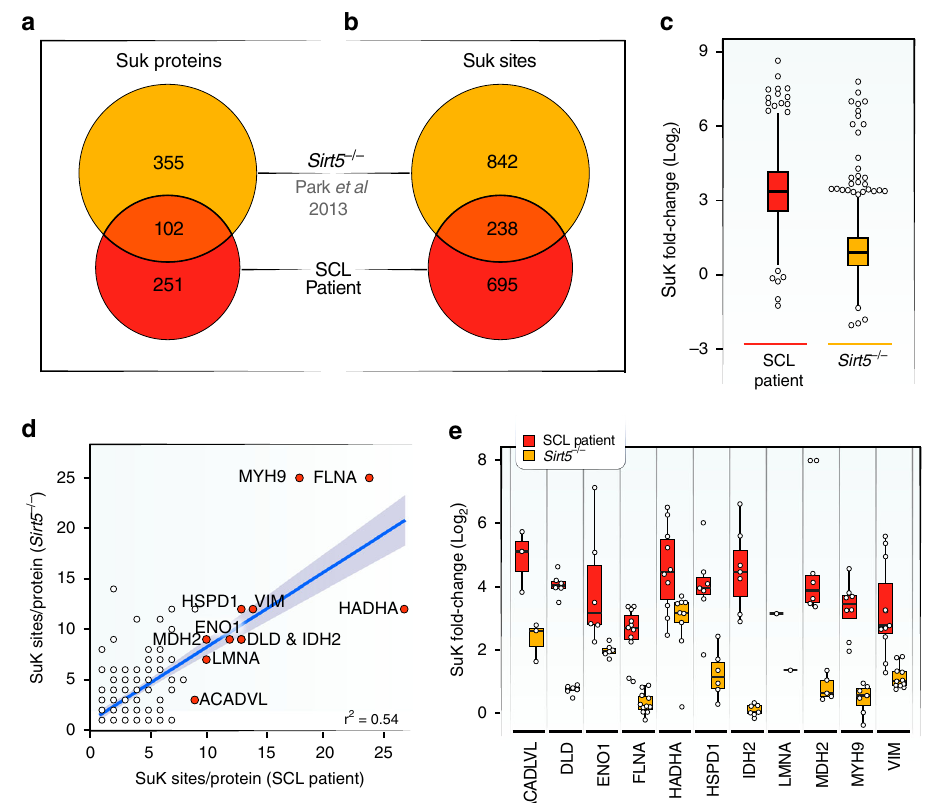
Fig. 3 Common succinylated targets in SCL and SIRT5 de fi ciencies. a Venn diagram of succinylated proteins identi fi ed in SCL patient fi broblasts and in mouse embryonic fi broblasts from Sirt5 − / − mice. Results from this study were compared to data deposited by Park et al. 26 . b Venn diagram showing number of sites that are susceptible to hyper-succinylation in both conditions. Pairwise sequence alignments identi fi ed each lysine showing signi fi cant changes in succinylation levels in both data sets. c Boxplot of fold-changes of lysine succinylation found in SCL-de fi cient patient cells and mouse embryonic fi broblasts from Sirt5 − / − mice ( n = 2 control fi broblast samples, n = 3 SCL patient-derived fi broblast samples; n = 2 control fi broblast samples, n = 1 patient-derived myotube samples; A technical replicate of patient-derived myotube samples was used). d Correlation of the number of suK marks on individual proteins found in data sets from SCL patient and Sirt5 − / − fi broblasts. Orange dots indicate the 11 most succinylated proteins in number of modi fi ed lysine sites identi fi ed in fi broblasts from SCL de fi cient patients (Total of 189 proteins, r 2 = 0.54). Gray band indicates 95% con fi dence interval. Red dots indicate the 11 proteins with the highest number of succinylation sites in SCL patient fi broblasts. e Boxplot showing fold-changes in succinylation of individual lysine residues among the 11 proteins with the highest numbers of suK marks. Note that only sites matched by sequence alignment of our human data to published mouse data are included in this analysis. The boxplots show the median, the fi rst to third quartile, the 1.5x interquartile ranges, and outliers. SuK =